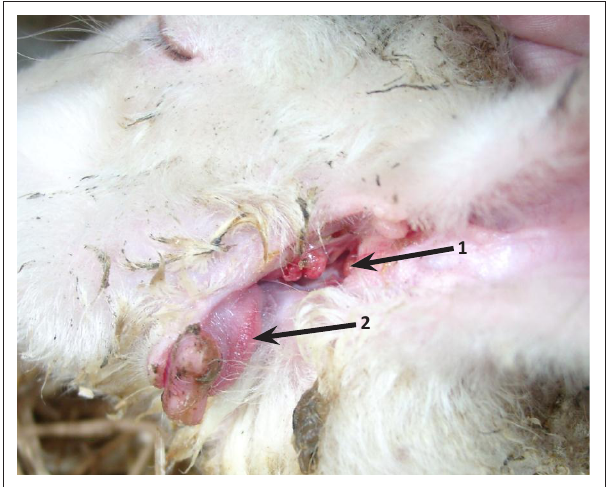
FIGURE 3: (1) Lamb 1 showing oro-auricular fistula and (2) presence of tongue Figure 3 tissue.